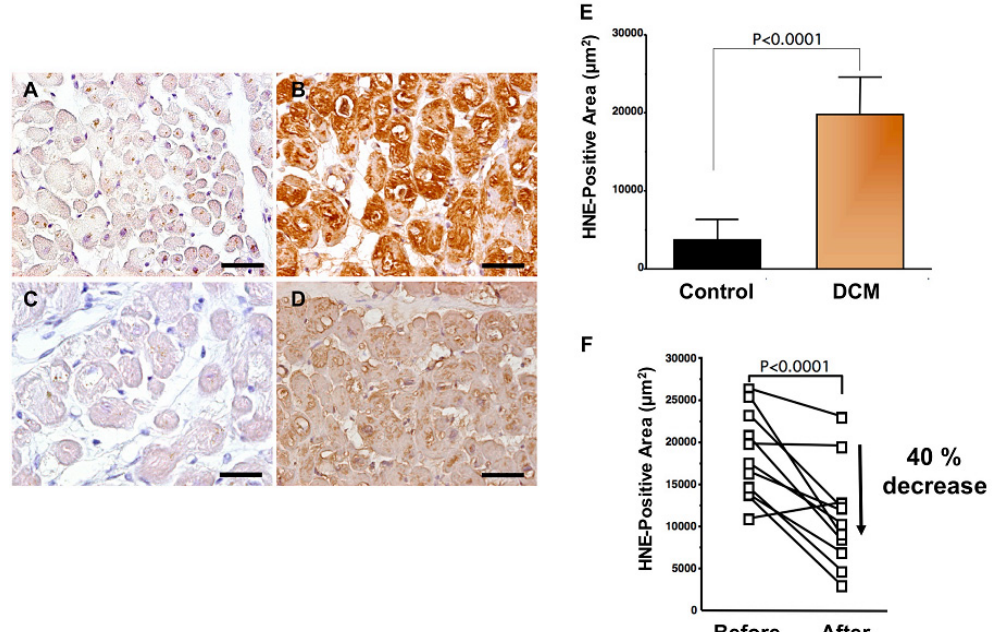
Figure 2. Carvedilol decreases elevated oxidative stress in the human failing myocardium